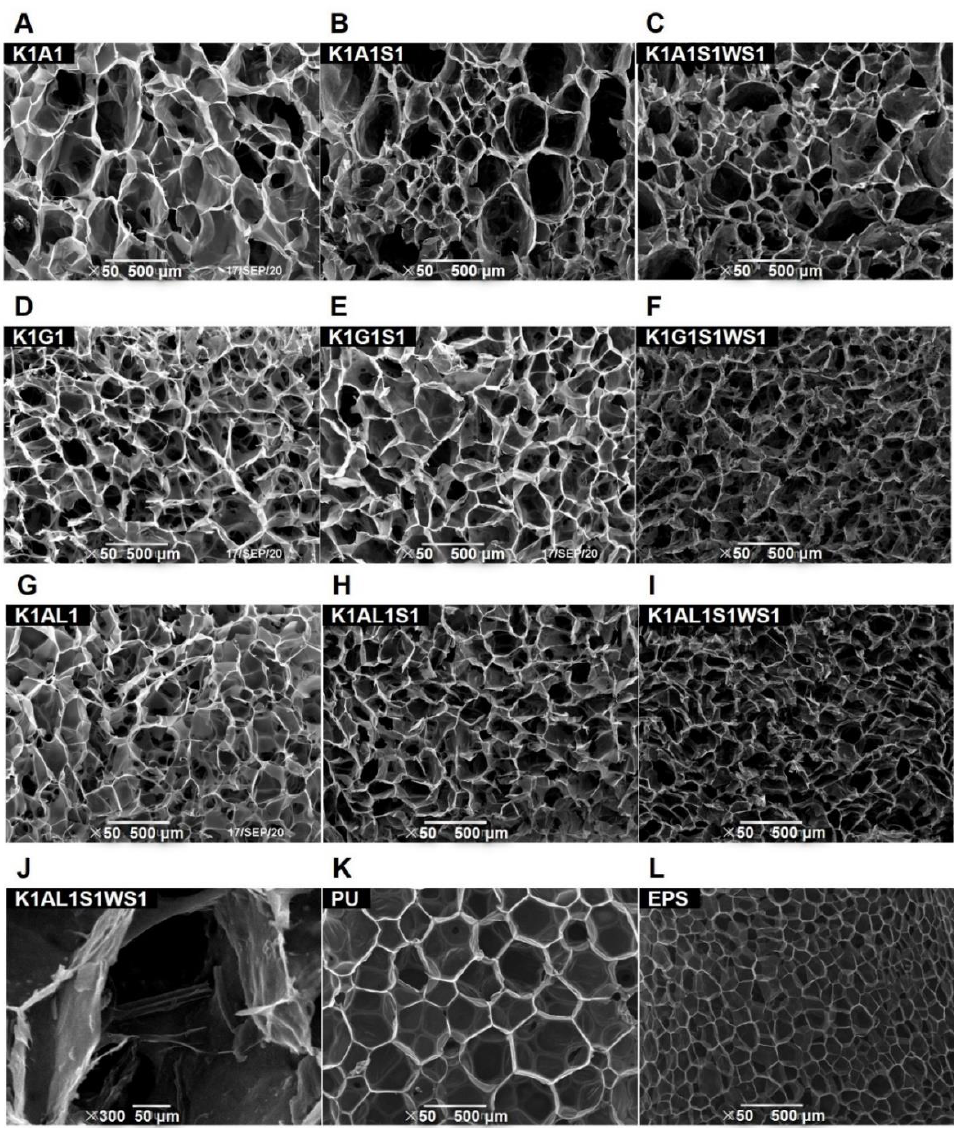
Figure 1. SEM images of konjac glucomannan (KGM)-based aerogels ( A – J ), polyurethane (PU) ( K ), and expanded polystyrene (EPS) ( L ).